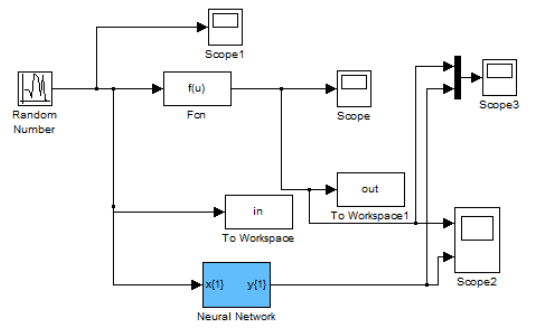
Figure 2. Simulink of Model with Using ANN Fig 2: the value of f(u)= G 1 (u)/ G 2 (u)/G 3 (u)/ G 4 (u): the transfer function of Longitudinal Dynamics Model / Lateral